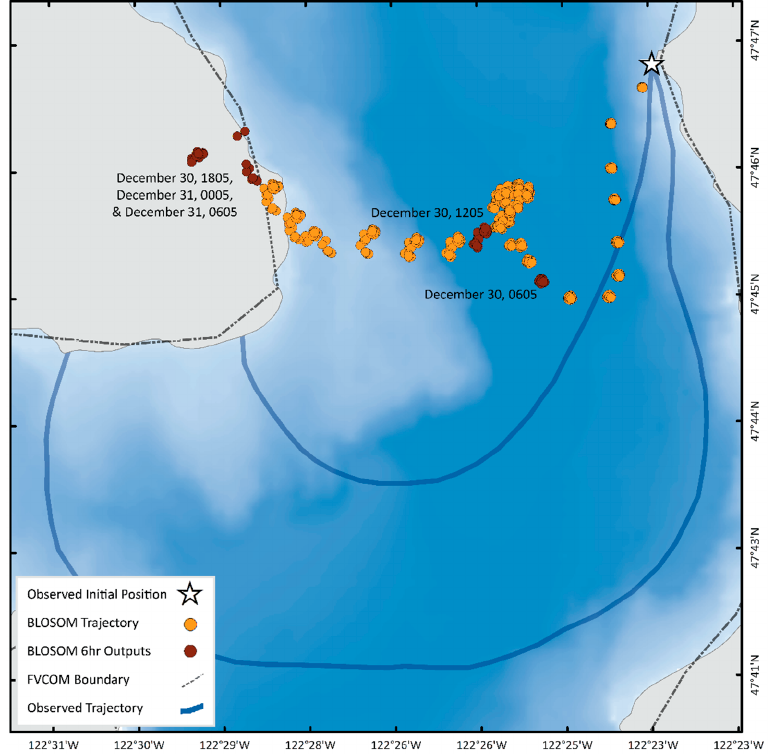
Figure A4. Same as Figure A1 but with a 36 min computational time step for BLOSOM.